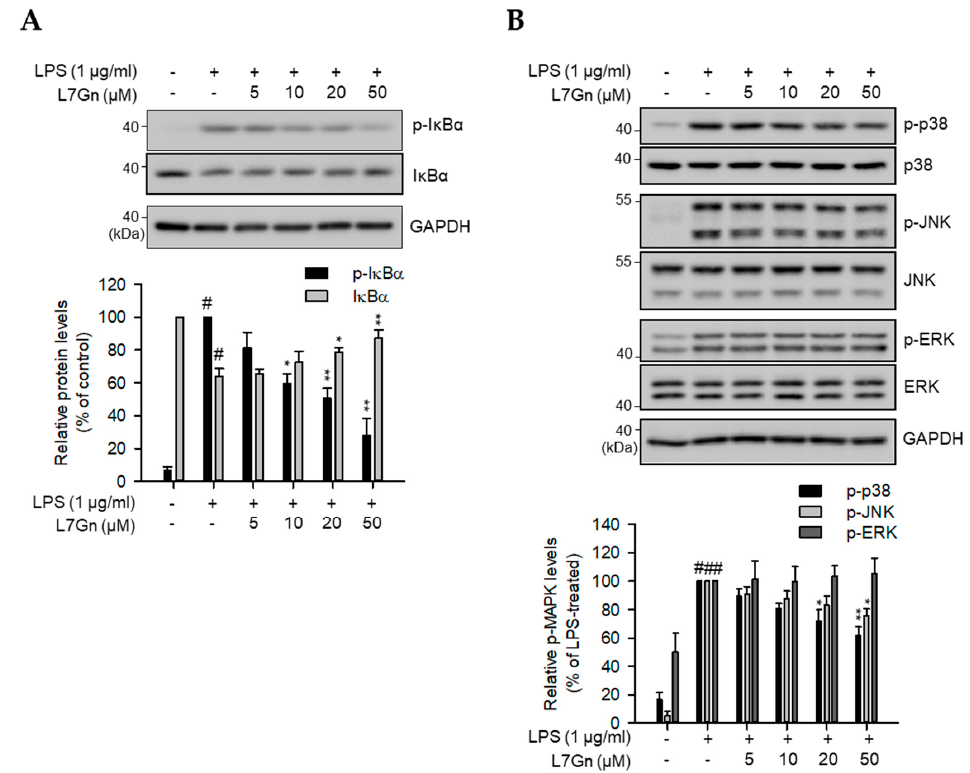
Figure 3. Inhibitory e ff ects of L7Gn on NF- κ B and MAPK activation. ( A and B ) RAW 264.7 macrophages were pre-treated with di ff erent concentrations of L7Gn (0, 5, 10, 20, and 50 µ M) for 2 h, followed by LPS (1 µ g / mL) stimulation for 3 min ( A ) or 15 min ( B ). Total cell lysates were prepared and immunoblot analysis was performed. The expression of p-I κ B α , I κ B α ( A ), p-p38, p38, p-JNK, c-Jun N-terminal kinase (JNK), p-ERK, and ERK ( B ) was detected using specific antibodies. Expression levels of p-I κ B α and I κ B α were normalized to GAPDH levels. Levels of phosphorylated MAPKs were normalized to the corresponding total MAPK levels. Results of the quantitative analyses of phosphorylated or total protein levels after normalization are shown (lower panel). Data represent the mean ± S.D. # p < 0.01 relative to the non-treated control group. * p < 0.05 and ** p < 0.01 relative to the non-treated (I κ B α in A ) or LPS-treated and 5 µM L7Gn-treated group ( B and p-I κ B α in A ).